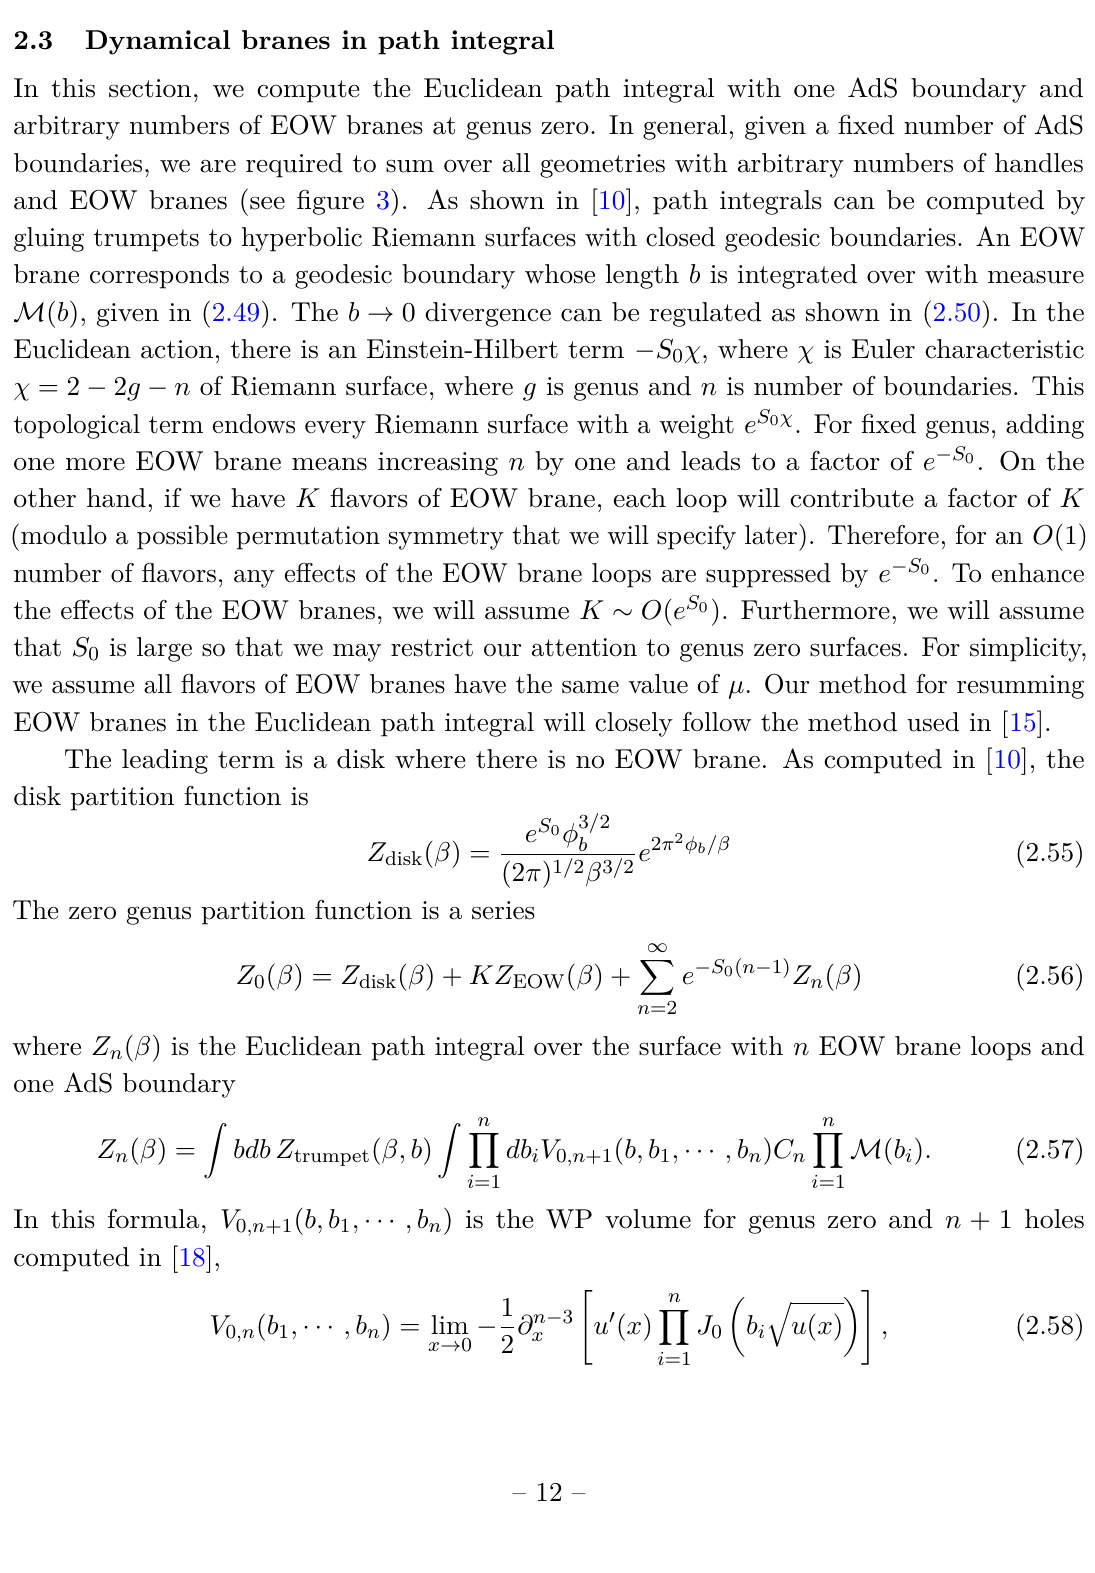
Figure 3. The partition function Z ( β ) in which all genera and EOW brane loops are summed. Red curve is AdS boundary and blue curves are EOW